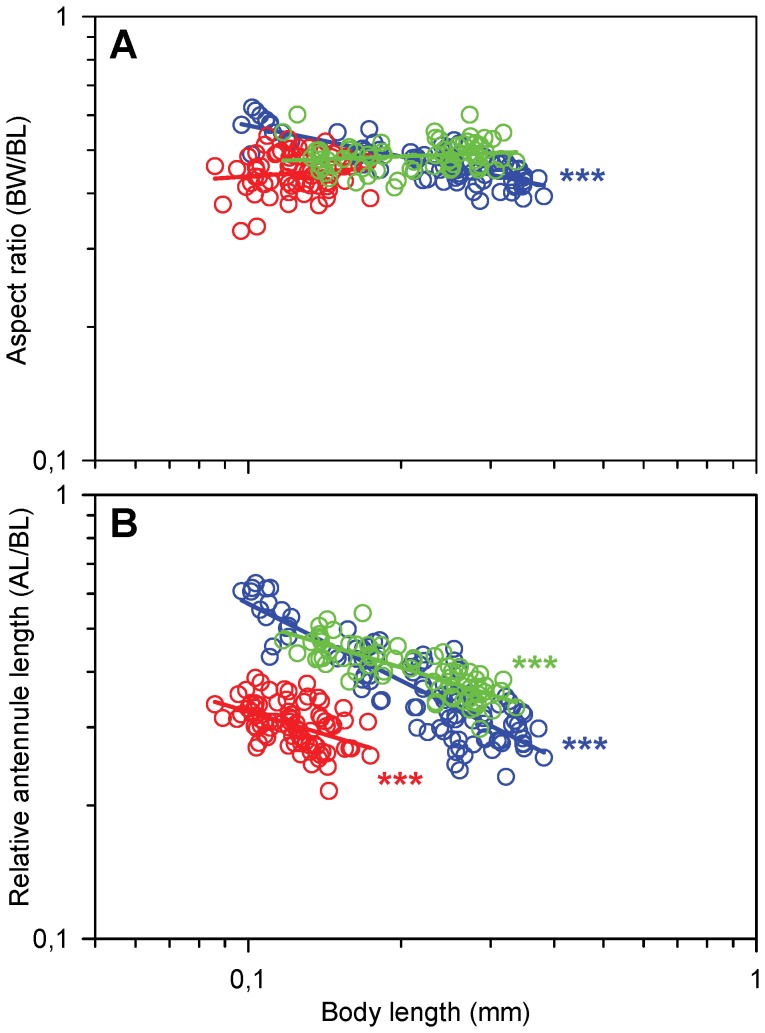
Morphology as function of body length (BL) in nauplii.Regression lines are power laws fitted to the data. A) Aspect ratio (AR, body width/body length). Blue circles, T. longicornis, power law equation: Log(AR)  = −0.23Log(BL) –0.48 (r2 = 0.69, p<0.0001, n = 88); red circles, O. davisae (slope  = 0.07, p = 0.47, n = 64); green circles A. tonsa, (slope  = 0.04, p = 0.10, n = 70), B) Relative antennule length (RAL, antennule length/body length). Blue circles, T. longicornis: Log(RAL)  = −0.58Log(BL) –0.82 (r2 = 0.75, p<0.0001, n = 100); red circles, O. davisae: Log(RAL)  = −0.34Log(BL)–0.83 (r2 = 0.21, p<0.0001, n = 83); green circles, A. tonsa: Log(RAL)  = −0.35Log(BL)–0.63 (r2 = 0.63, p<0.0001, n = 71).